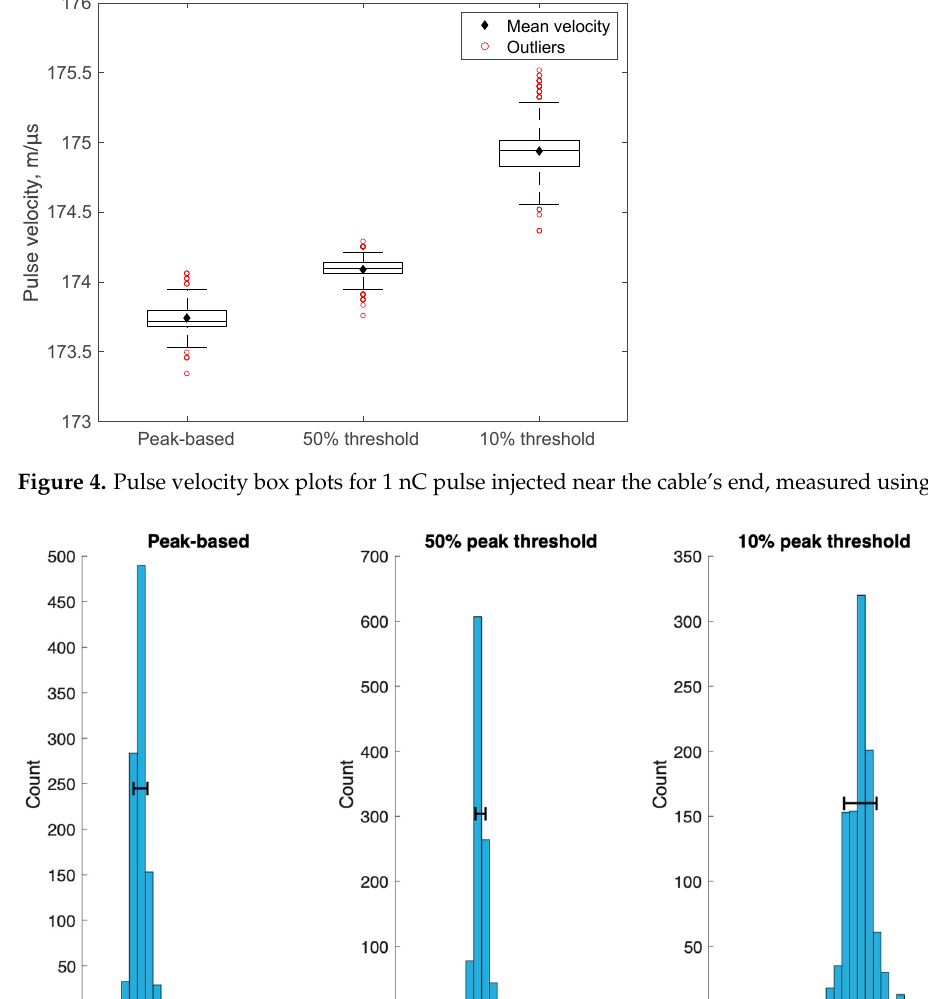
Figure 7. Pulse velocity histograms for 1 nC pulses (1000 total) injected at the far end of the cable, including SD around the mean, measured using HFCT. Figure 8. Pulse velocity box plots for 1 nC pulse injected near the cable’s end, measured using the IEC 60270-compliant system.